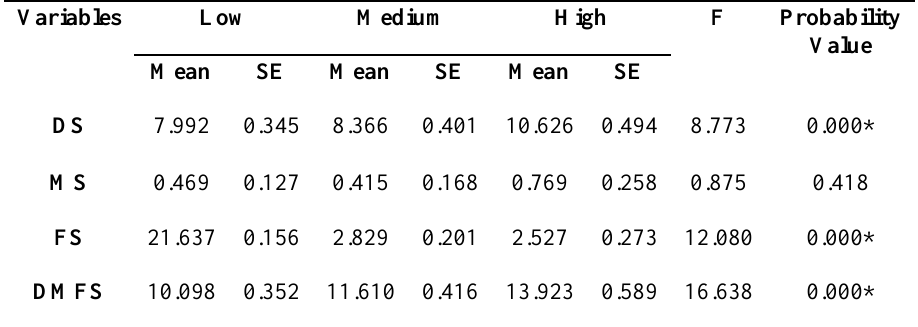
Table 2: Dental caries experience according to depression grade Variables Low Medium High F Probability